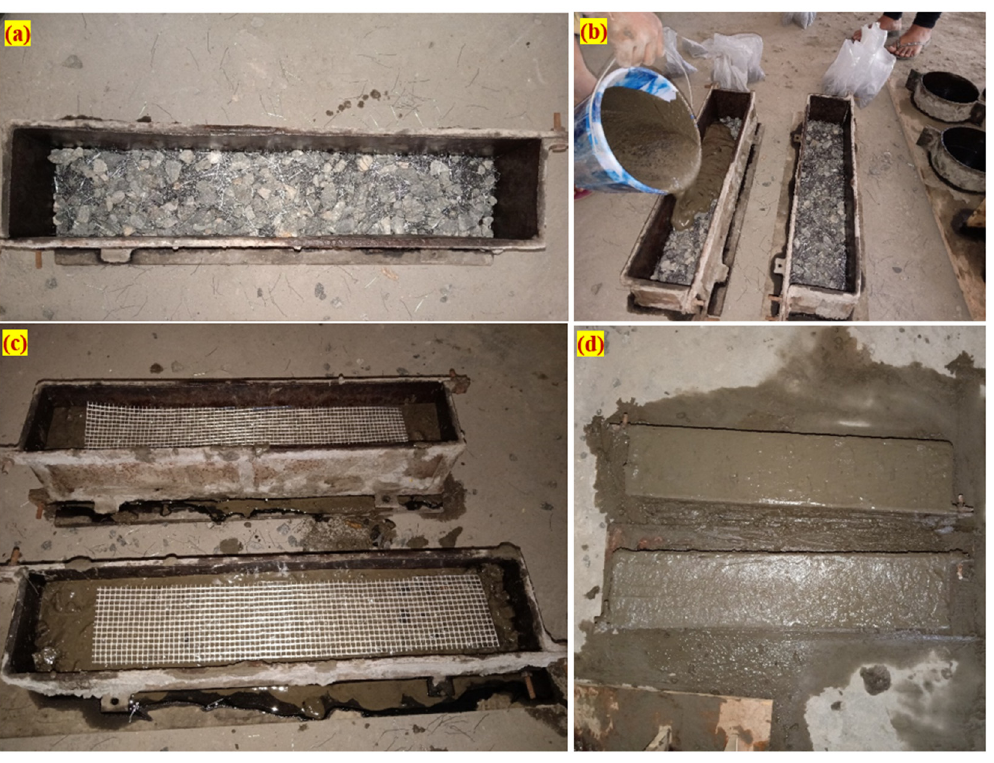
Figure 3. Casting process. ( a ) Mild filled with fibres and aggregates, ( b ) grout injection, ( c ) GFM addition, and ( d ) beam after finishing.